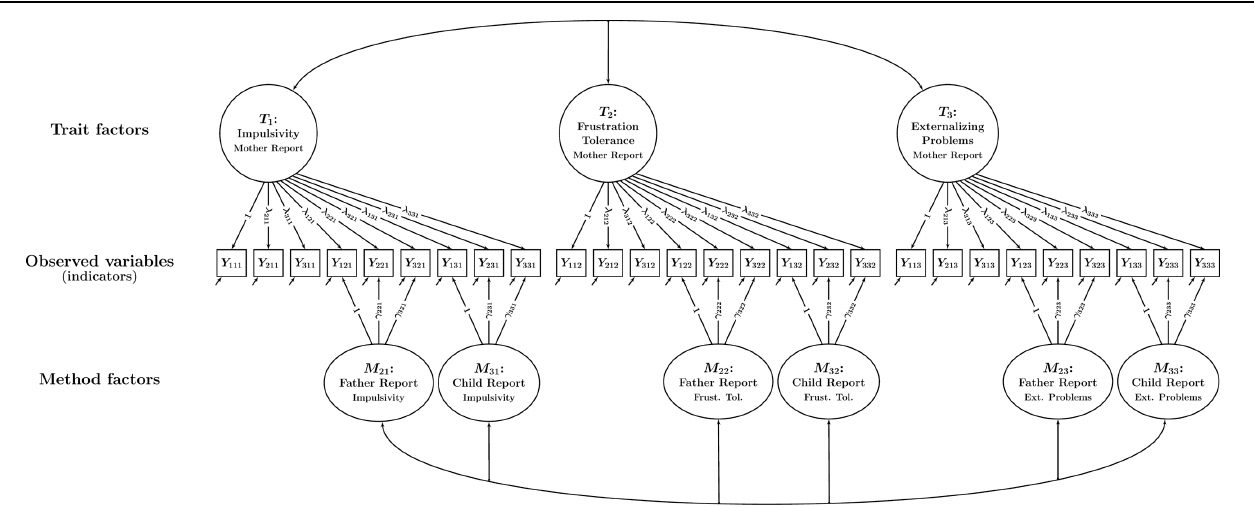
FIGURE 3 | Path diagram illustrating a CT-C( M – 1) model with a single trait factor per trait. In the example, there are three traits and three methods. Each trait-informant combination is measured by three observed variables (indicators) Y imt ( i = indicator, m = method or type of informant, t = trait). Trait factors T t are shown at the top, trait-specific method factors M mt at the bottom of the figure. The parameters λ imt and γ imt denote trait and method factor loadings, respectively. All trait factors can be correlated and all method factors can be correlated as indicated by double-headed arrows. Correlations between trait and method factors pertaining to the same trait are not